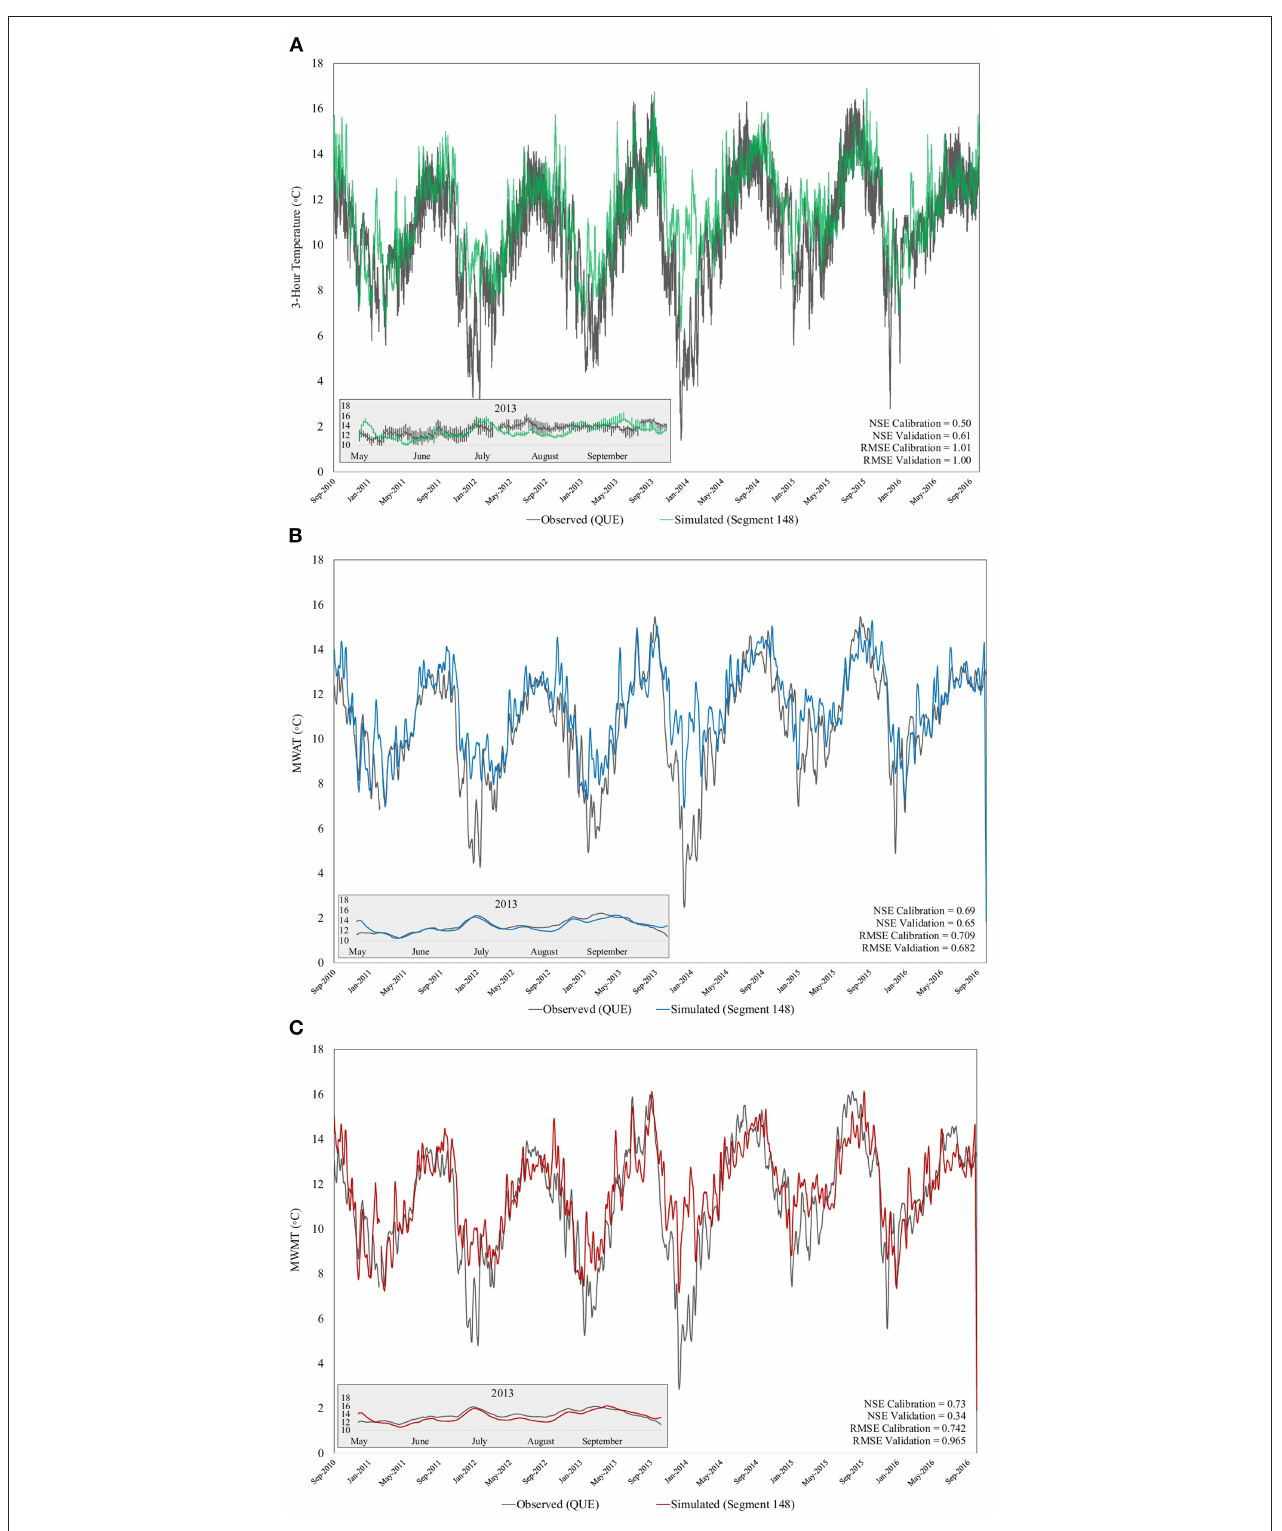
FIGURE 3 | (A) Measured and simulated stream temperatures at a 3 h timestep for the outlet of the South Fork and (B) resulting MWAT values and (C) resulting MWMT values for the measured and simulated stream temperatures. The model was calibrated to the summer months (May 1st–September 30th) 2011–2013, and validated during the summer months of 2014–2016. Inserted plates in each figure show a close-up of one summer time period, May–September 2013.